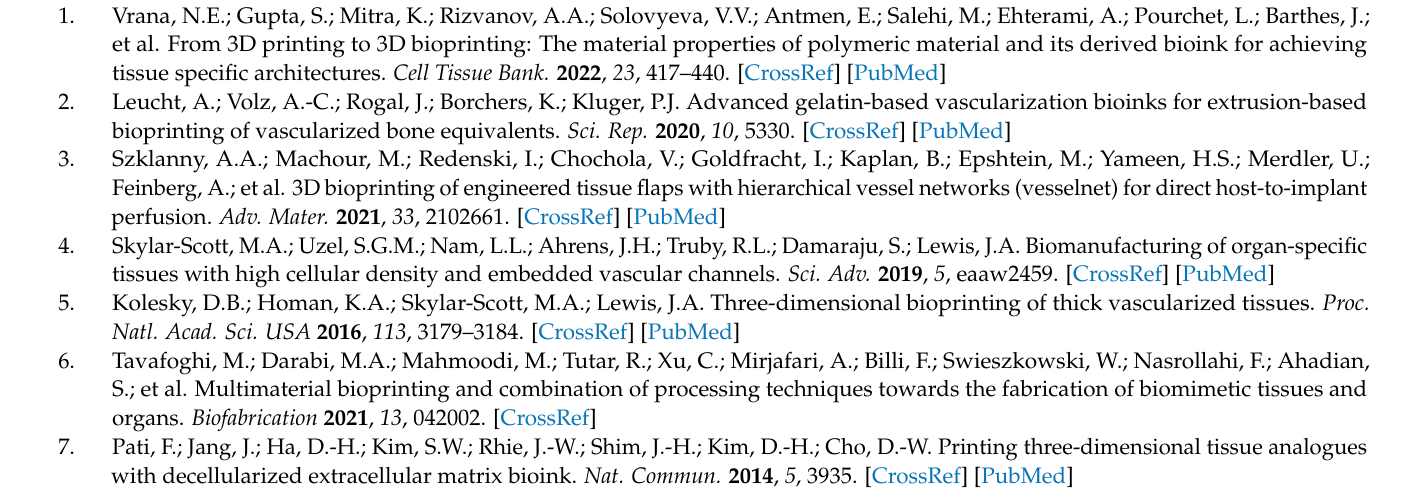
Figure S2: 3D-printed PVA grid structure with dLM-PEG, Figure S3: The viscosity and storage modulus of different formulations at low (1 Hz) frequency, Figure S4: Channel formation with dLM-PEG-T after PVA dissolution (side view), Figure S5: Trilobular structure with dLM-PEG filled inside, Figure S6: Side view of the trilobular structure with dLM-PEG filled inside on day 0, day 7, and day 21, Figure S7: Long term culture and degradation of dLM-PEG-T structure, Figure S8: The collagen control used as co-culture control with HepG2 and NIH 3T3 cells, Figure S9: Migration study of HepG 2 and NIH 3T3 cells seeded over 600 µ m thick dLM-PEG-T hydrogel at different time points, Figure S10: Urea secretion by the co-culture of HepG2 and NIH 3T3 cells, Figure S11: Liver lobule-on-chip concept for future studies; Supplementary Video S1: Micro-channel in PBS